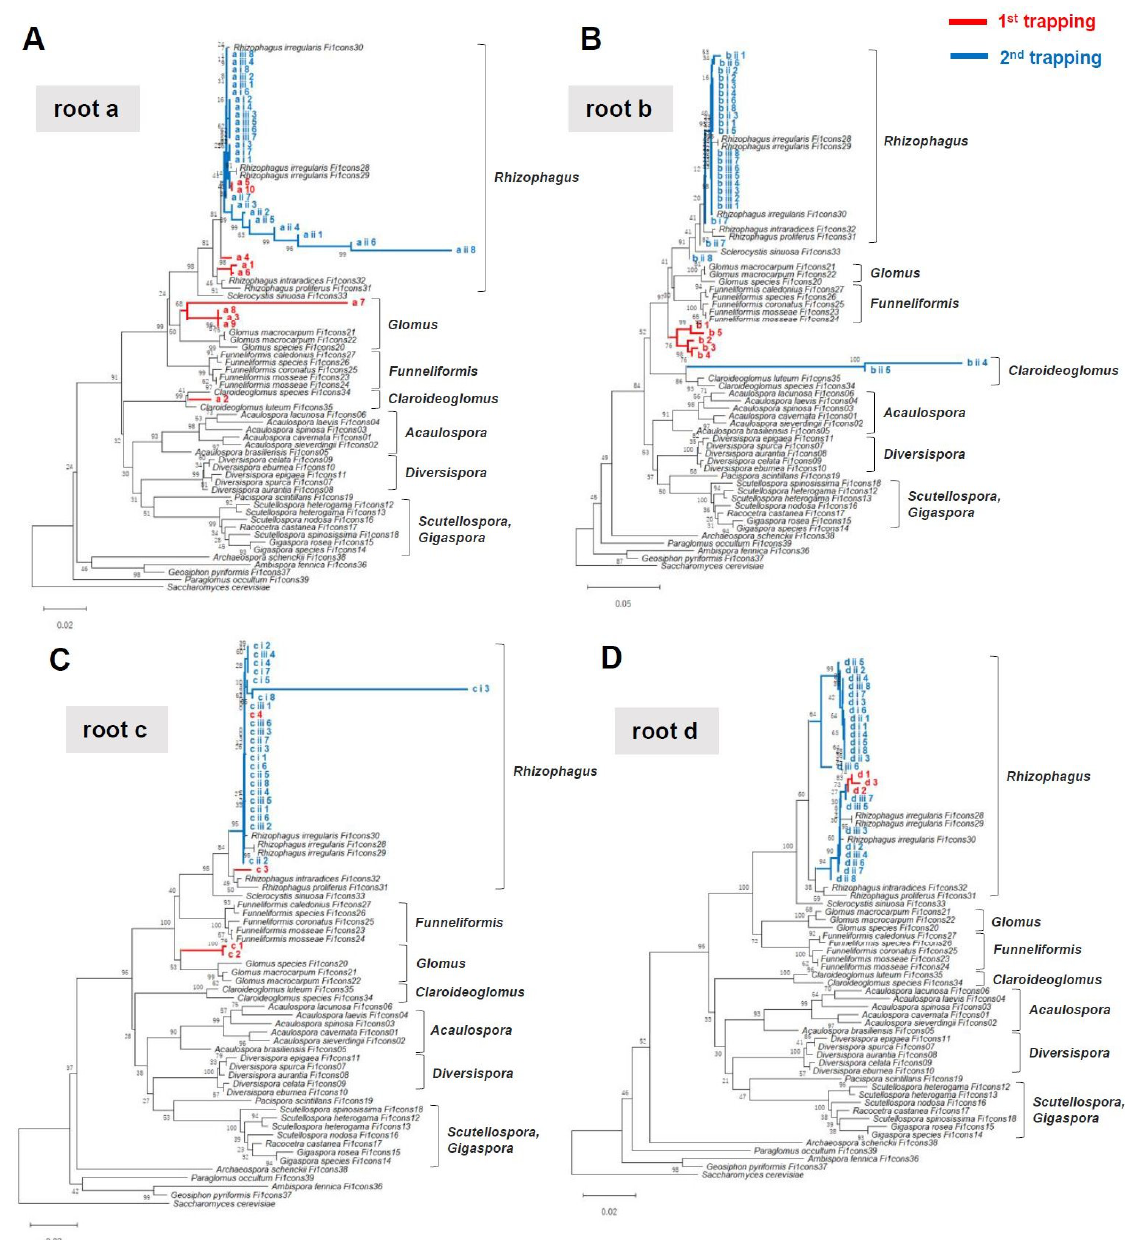
Figure 3. Phylogenetic placement of AMF rDNA mycothalli partial sequences. For phylogenetic tree construction, the first mycothalli “meta”-sequences ( n = 3–10, shown by red lines) and second meta-sequences ( n = 6–8, shown by blue lines) from different roots, 39 AMF rDNA consensus sequences [32], and the Saccharomyces cerevisiae rDNA sequence were used. The S. cerevisiae sequence was used as the outgroup. A – D show the analyses for roots a, b, c, and d, respectively. Phylogenetic trees were generated using the neighbour-joining method. The percentage of replicate trees in which the associated taxa clustered together in the bootstrap test (i.e., 500 replicates) are shown next to the branches. Evolutionary distances were computed using the maximum composite likelihood method.